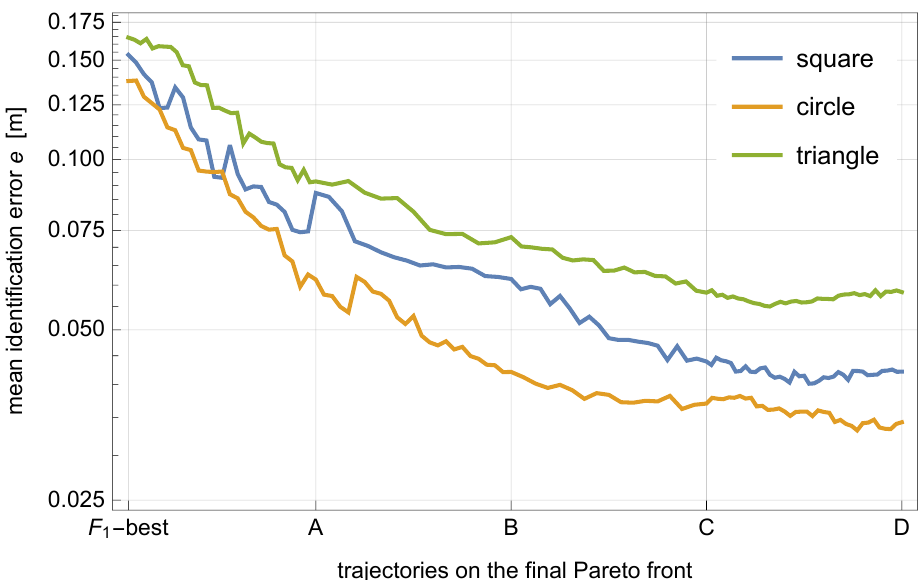
Figure 11. Mean identification error for the trajectories on the final Pareto fronts. Labels “A” to “D” correspond to the labels in Figures 8–10, while “ F 1 -best” denotes the trivial F 1 -best